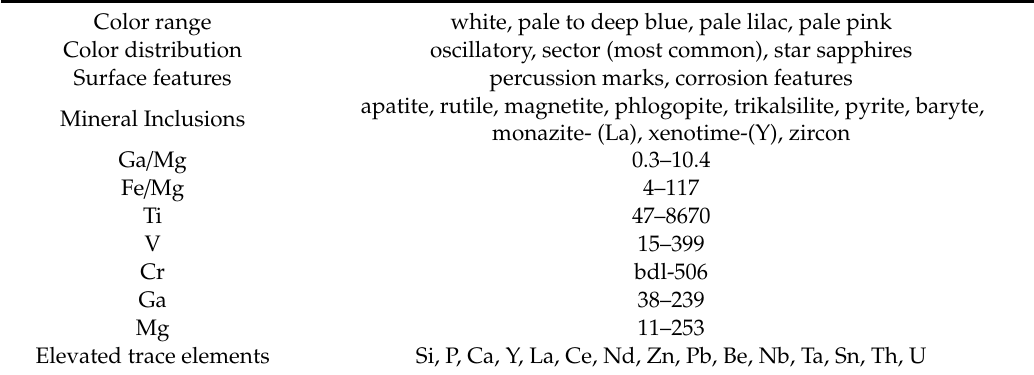
Table 1. Summary of main findings of Harris et al. (2017) [15] for the Orosmayo sapphire suite (bdl = below detection